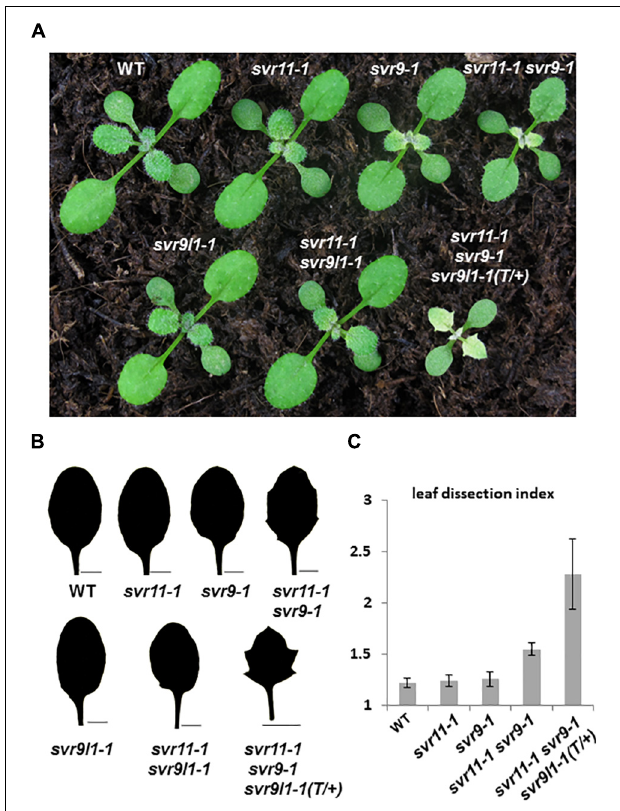
FIGURE 6 | Genetic interaction between SVR11 and SVR9 . (A) Representative 12-day-old wild-type, svr11-1 , svr9-1 , svr11-1svr9-1 , svr9l1-1 , svr11-1 svr9l1-1, and svr11-1 svr9-1 svr9l1-1(T/+) . (B) The third leaf silhouettes of 20-day-old plants. Bar for 2,000 µ m. (C) Quantitative comparisons of leaf shapes in WT, svr11-1 , svr9-1 , svr11-1 svr9-1 , and svr11-1 svr9-1svr9l1-1(T/+) shown in (B) , based on the leaf dissection index (perimeter 2 /4 π ∗ leaf area). Fifteen individuals of each genotype were used in the statistical analysis.